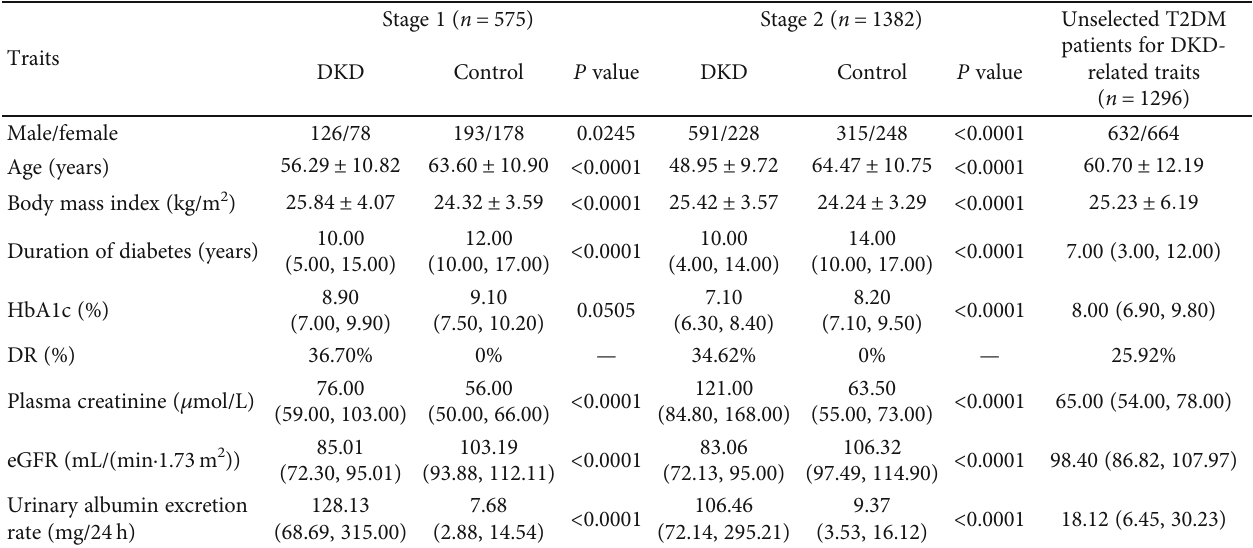
Table 1: Demographic and clinical characteristics of study participants.